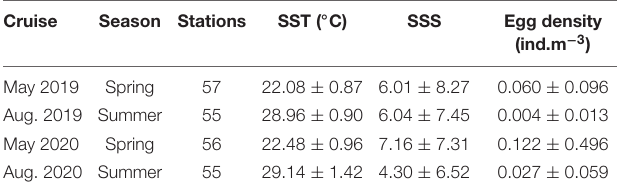
TABLE 1 | Summary of the surveys and the average value ( ± SD) of data